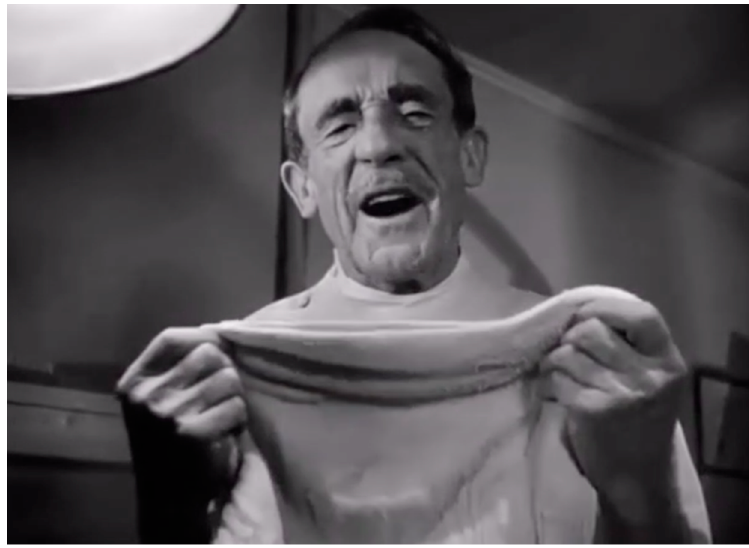
Figure 14. Image from Dark Passage (1947) [37].